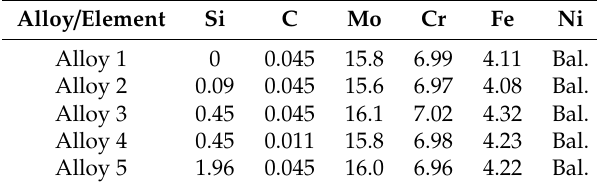
Table 1. Chemical composition of the experimental alloy (wt.%) Alloy /